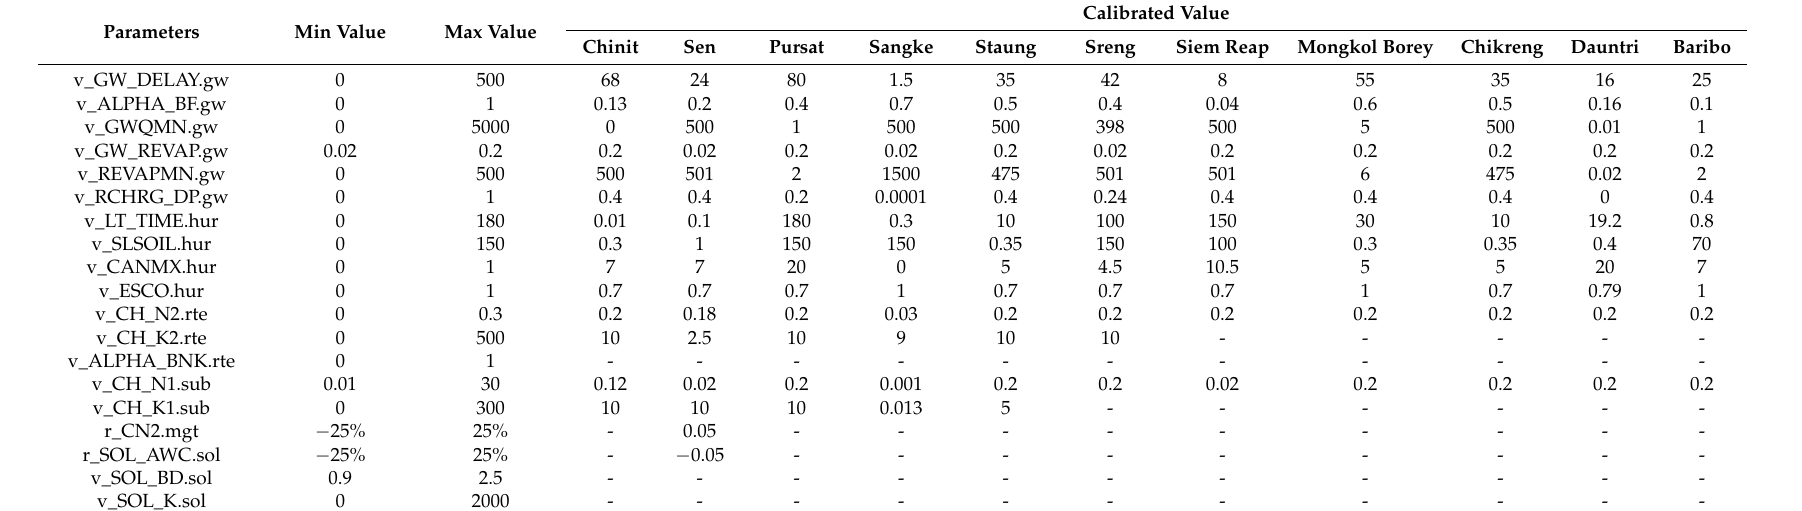
Table A2. SWAT model-calibrated parameter values for all 11 river sub-basins of the Tonle Sap Lake.